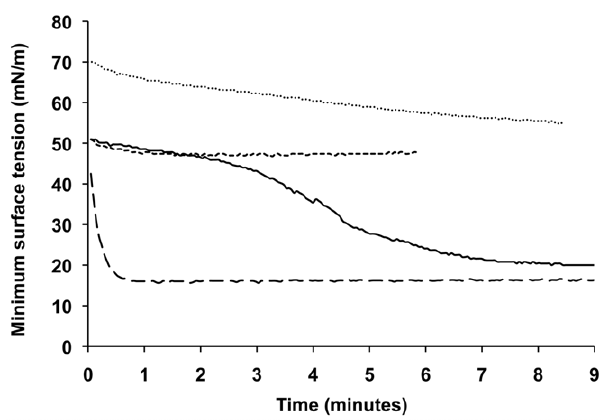
Figure 6. PLUNC interaction with albumin in the pulsating bubble surfactometer. The pulsating bubble surfactometer was used to measure dynamic surface tension in solutions containing mixtures of PLUNC and bovine serum albumin (BSA). Plotted values represent surface tension minima over time for Tris buffer ( NNNN ), BSA at 10 mg/mL (----), PLUNC at 10 m g/mL ( _ _ ) or PLUNC (10 m g/mL) with BSA (10 mg/ mL) (—). In the presence of BSA, it takes longer for PLUNC to reach its saturation value for minimum surface tension.